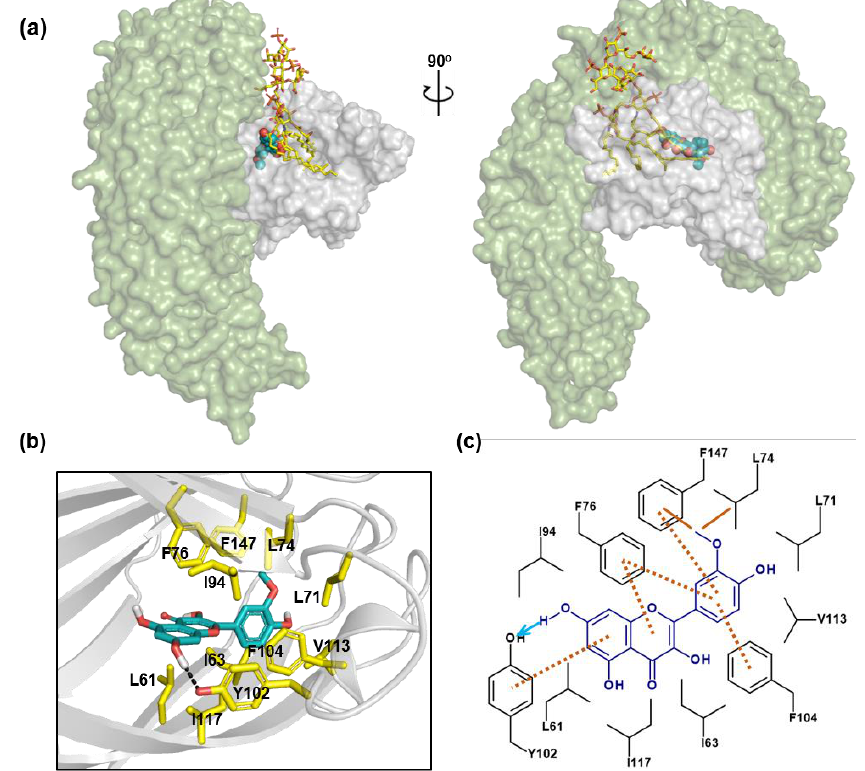
Figure 5. Binding interactions between isorhamnetin and MD-2. ( a ) Isorhamnetin (blue and red sphere) overlapped with LPS (yellow stick) in the hydrophobic binding cavity of MD-2 (gray) together with TLR4 (green), and its 90-degree rotated complex structure is shown. ( b ) Overview of the MD-2–isorhamnetin complex. Isorhamnetin is shown as sky blue sticks, and important residues in MD-2 (gray ribbon cartoon) are shown as yellow sticks. ( c ) Two-dimensional illustration of the MD-2–isorhamnetin docking pose showing hydrophobic interactions and hydrogen bonding interactions.